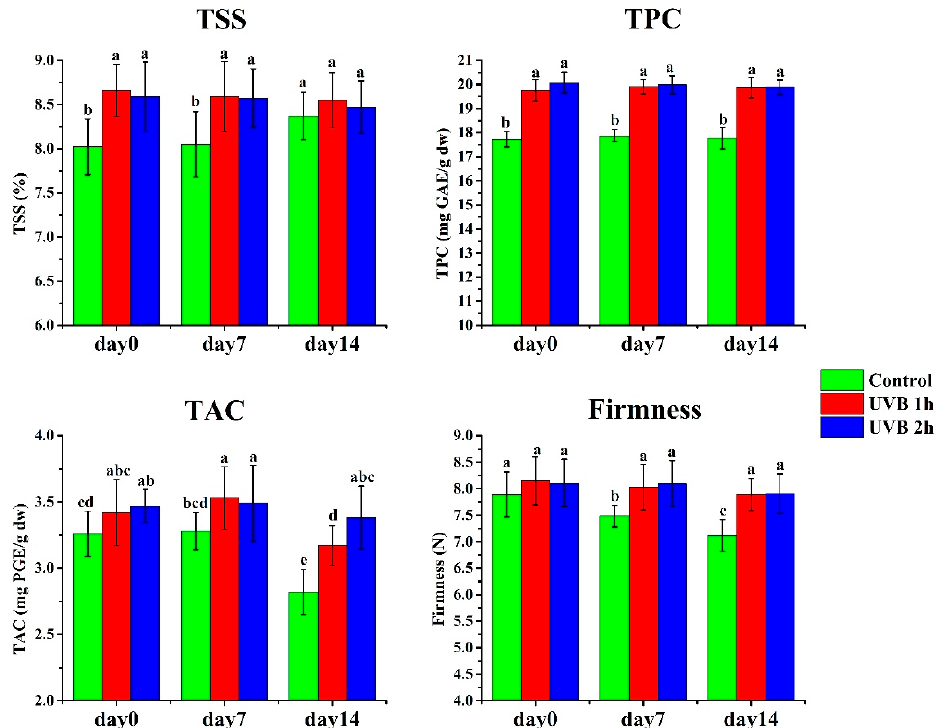
Figure 3. Effects of UV-B treatment on strawberry fruit quality. TSS, total soluble solids (Brix%); TPC, total phenolic content (mg GAE/g dry weight)), and TAC, total anthocyanin content (mg PGE/g dry weight). The data are based on ten biological replicates. * p < 0.05.